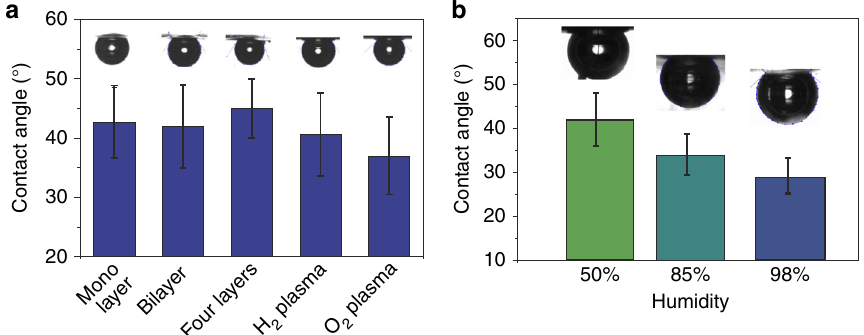
Fig. 3 Graphene contact angles measured by the captive bubble method. a Contact angles of water on free-standing, monolayer, bilayer, four-layer graphene and graphene modi fi ed with H 2 and O 2 plasma, measured using the captive bubble method. The measurement was reproduced on fi ve samples and the error bar represents the standard deviation. b Contact angle of water on free-standing graphene in 50%, 85%, and 98% relative humidity. The measurement was reproduced on two samples and the error bar represents the standard